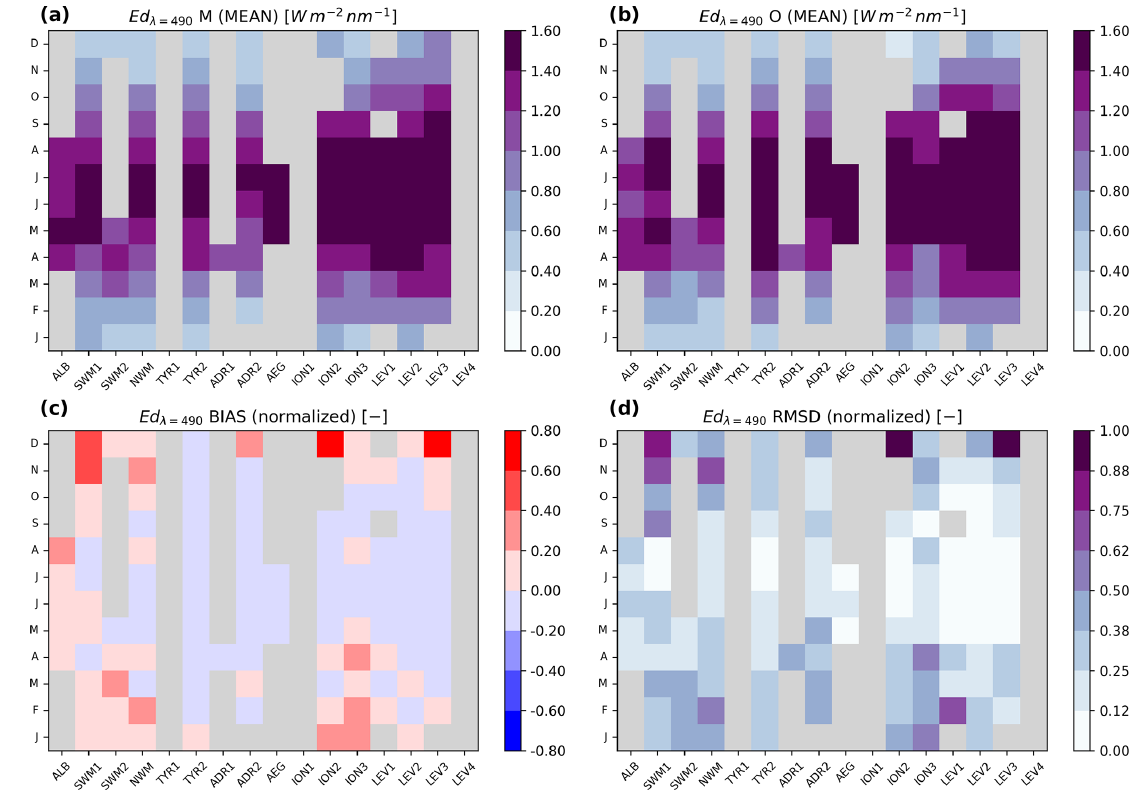
Figure 10. Same as Fig. 8 for E d (λ = 490 , 0 − )